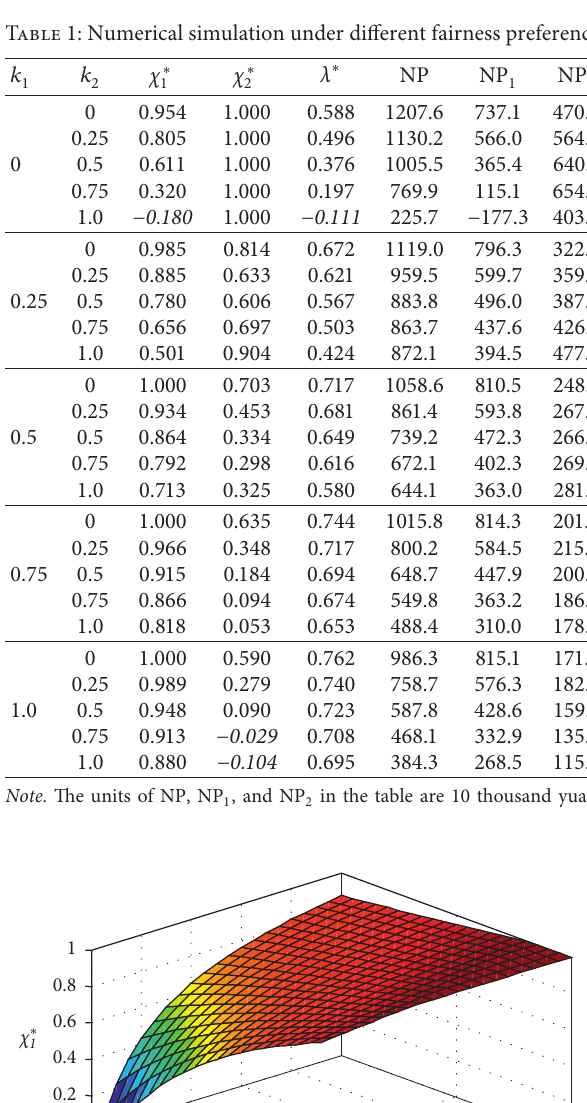
Table 1: Numerical simulation under different fairness preference.